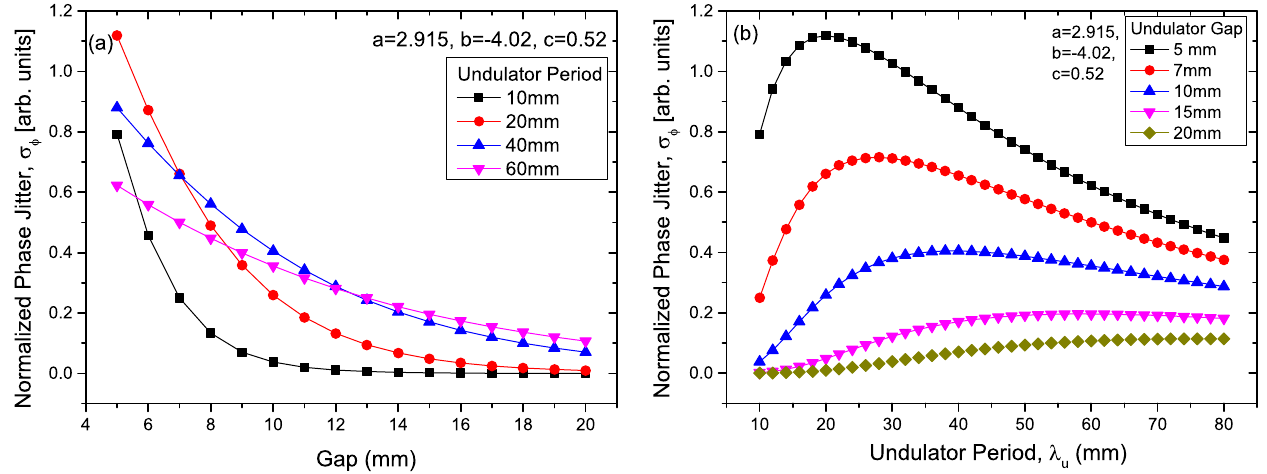
FIG. 3. The normalized phase jitter as a function of the undulator gap (a) and as a function of the undulator period